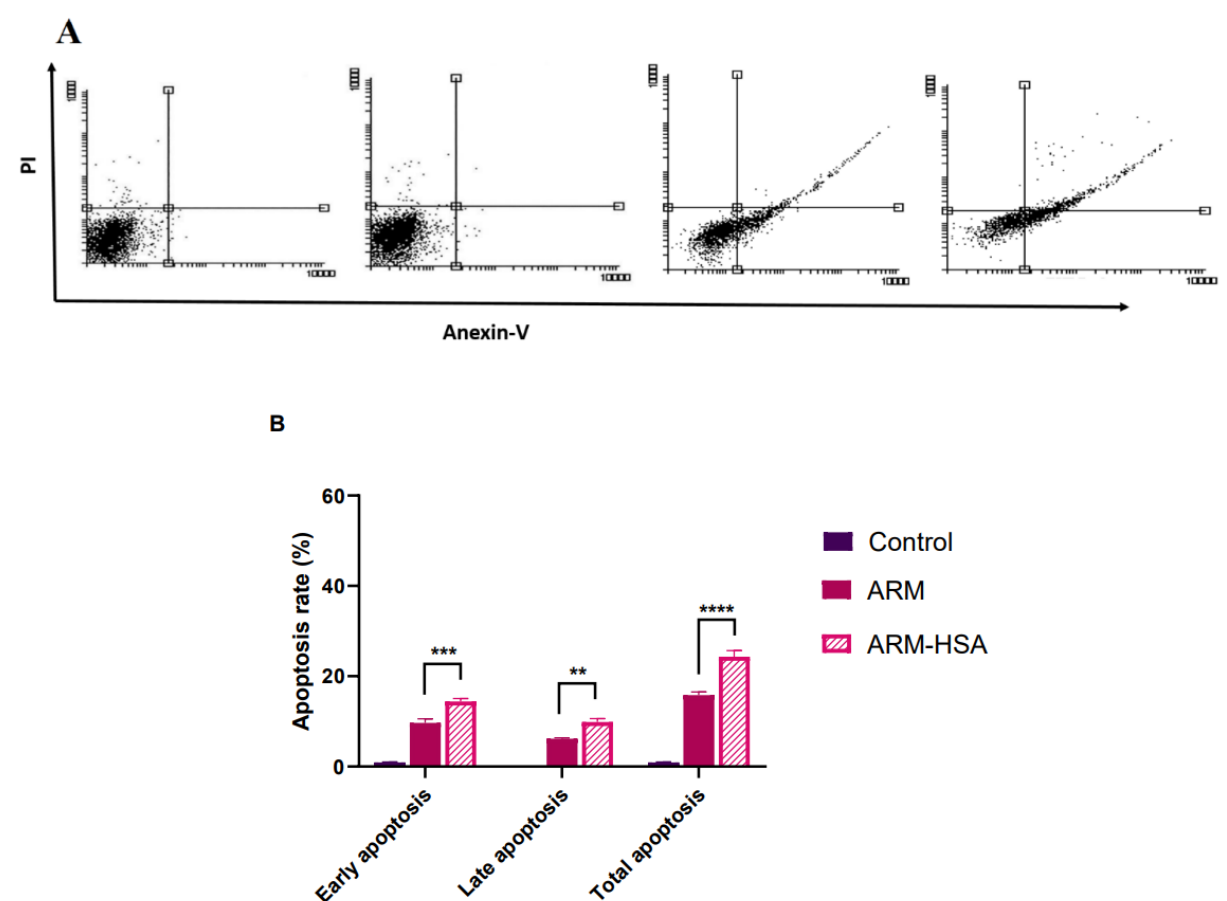
Figure 7. Results of Annexin-V FITC/PI assay after 24 h of drug treatment. Dot plot diagrams show apoptosis in the treatment groups ( A ). The bar chart shows early, late, and total apoptosis separately ( B ). Asterisks show the statistically significant difference between various treatments. (** p < 0.01, *** p < 0.001, and **** p < 0.0001). Data are presented as mean ±